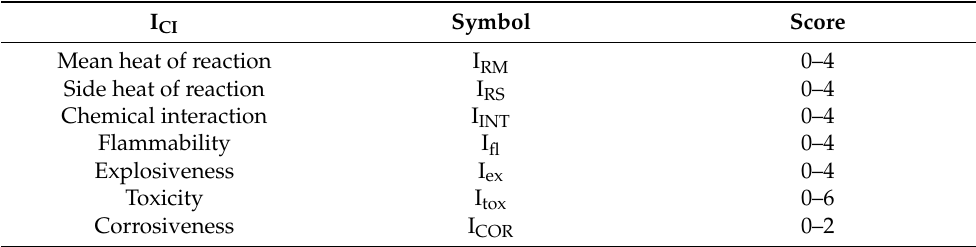
Table 1. The score for chemical safety